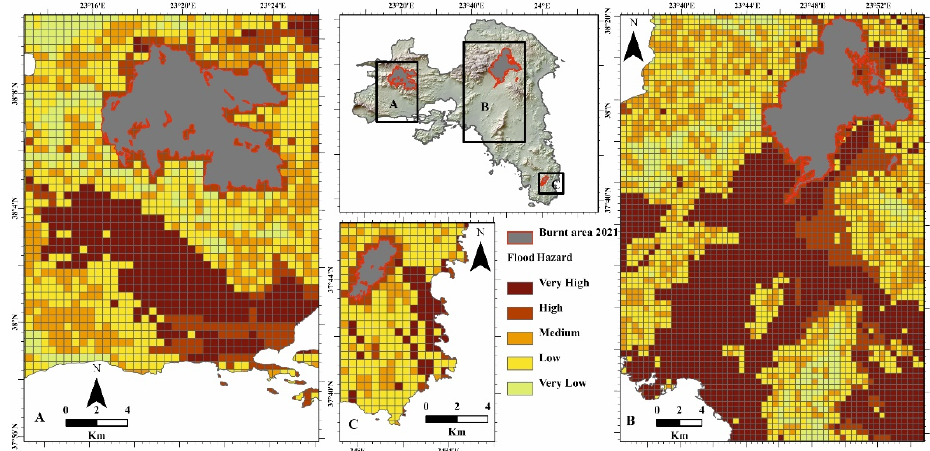
Figure 11. Flash flood hazard in the fire-affected area of Attica using a Boolean logic-based model: ( A ) Villia, ( B ) Varimpompi, and ( C ) Sounion National Forest.